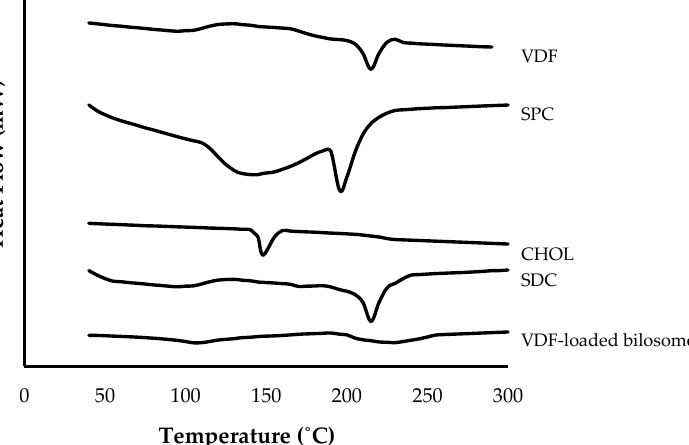
Figure 5. DSC thermograms of pure VDF, soybean phosphatidylcholine (SPC), cholesterol (CHOL), sodium deoxycholate (SDC), and optimized bilosomal formulation.